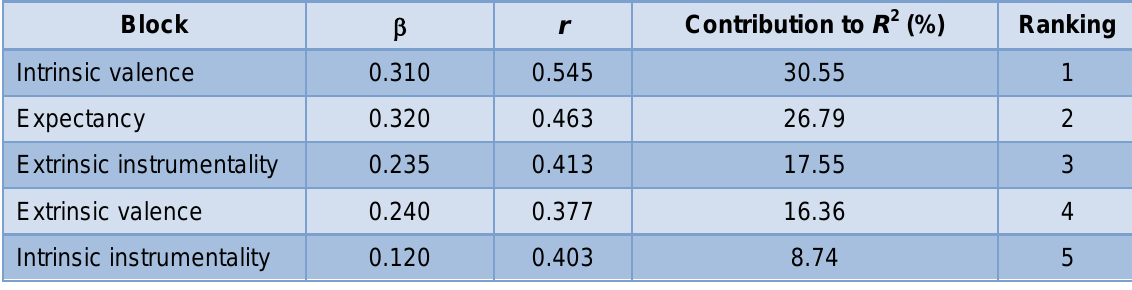
Table 6 Explanation of workers’ motivational